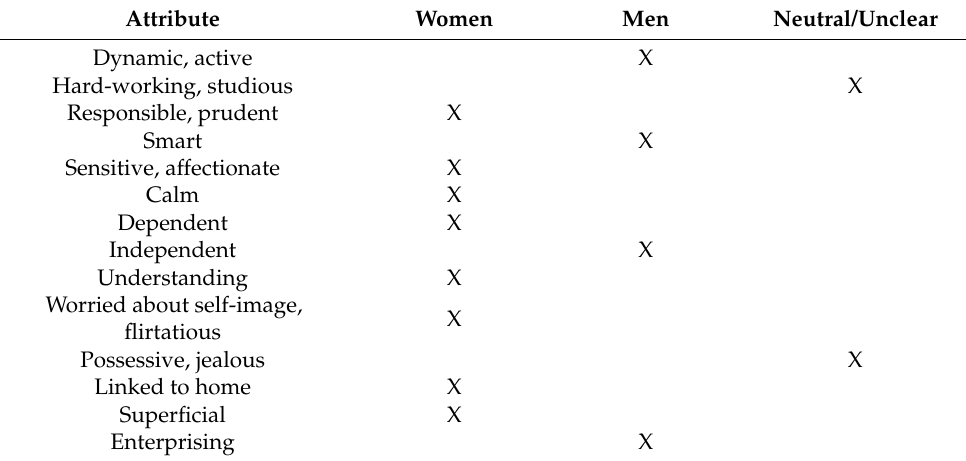
Table 1. Categorization of items based on stereotypical attributions for women and men. Attribute Women Men